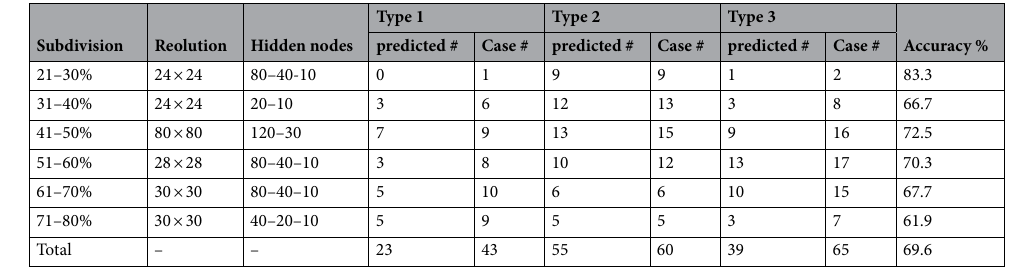
Table 2. Classification results of the ICH into subtypes using the validation set for the six subdivisions.